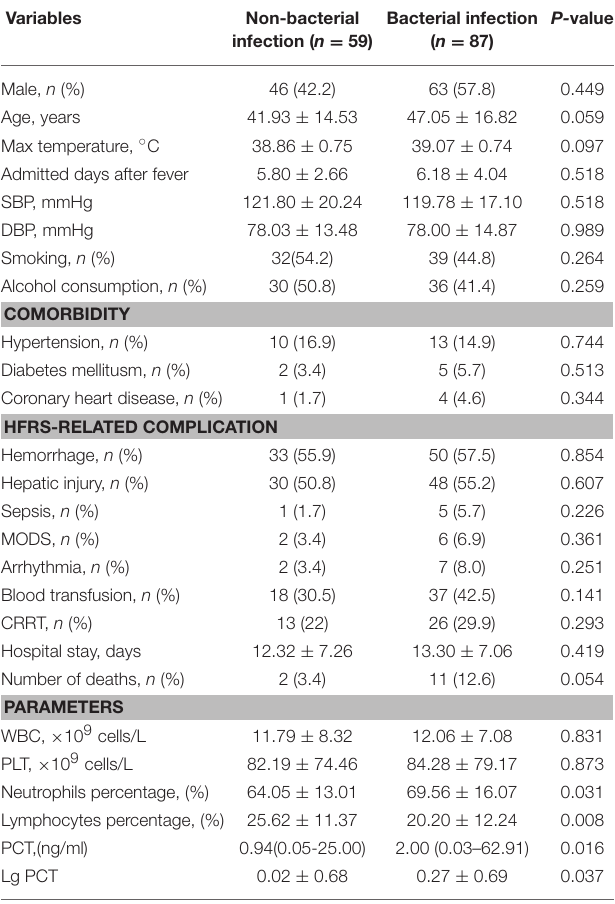
TABLE 4 | Demographics, clinical data and laboratory perameters at admission in HFRS patients with and without bacterial infection.